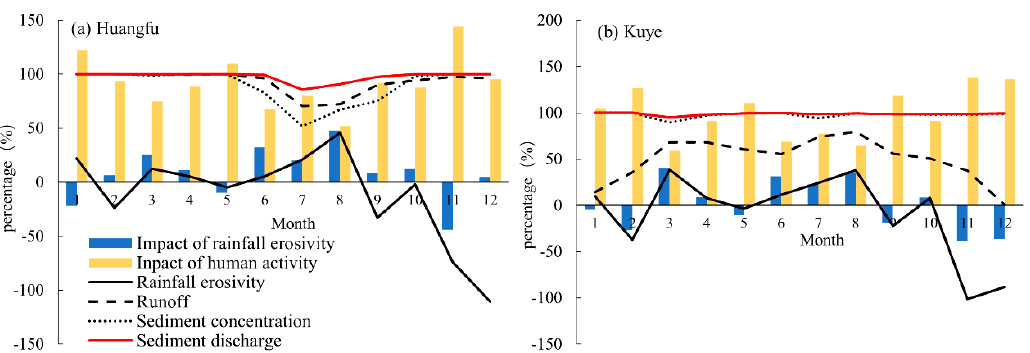
Figure 7. The contribution of rainfall and human factors to the changes of monthly sediment discharge and the percentages of decreased rainfall, runoff and sediment concentration in the change period compared with the baseline period in the Huangfu basin ( a ) and the Kuye basin ( b ) (a reduction percentage of 100% for an item means that the item became none in the change period).